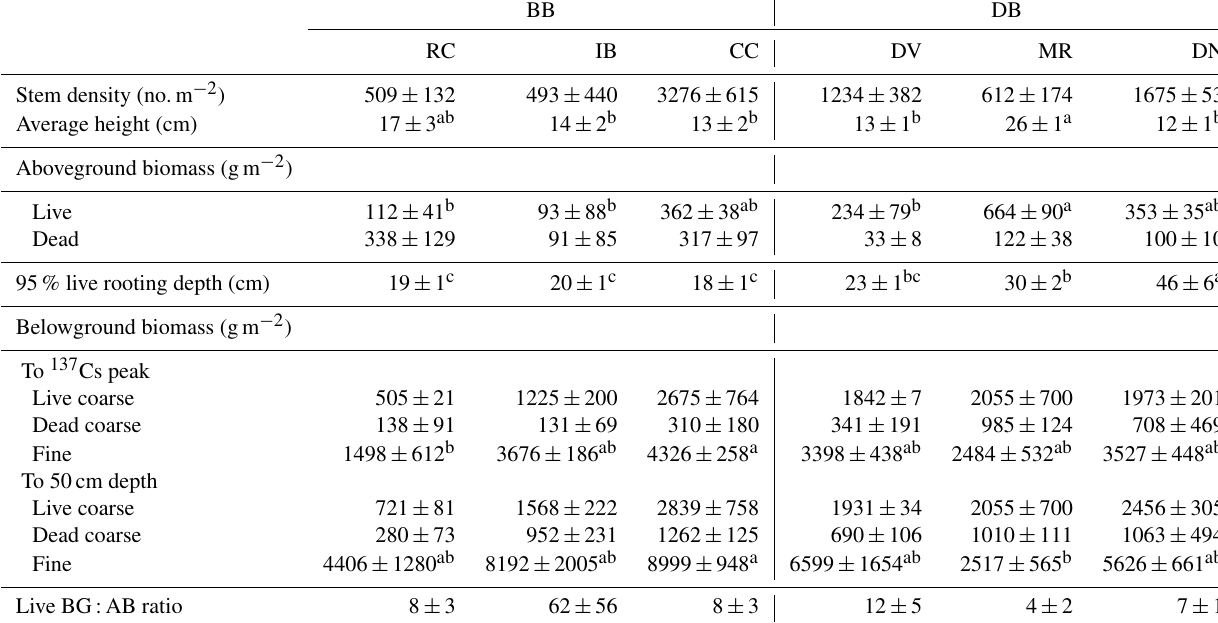
Table 2. Vegetation structure in Spartina alterniflora salt marshes in two mid-Atlantic estuaries ( n = 3, ± standard